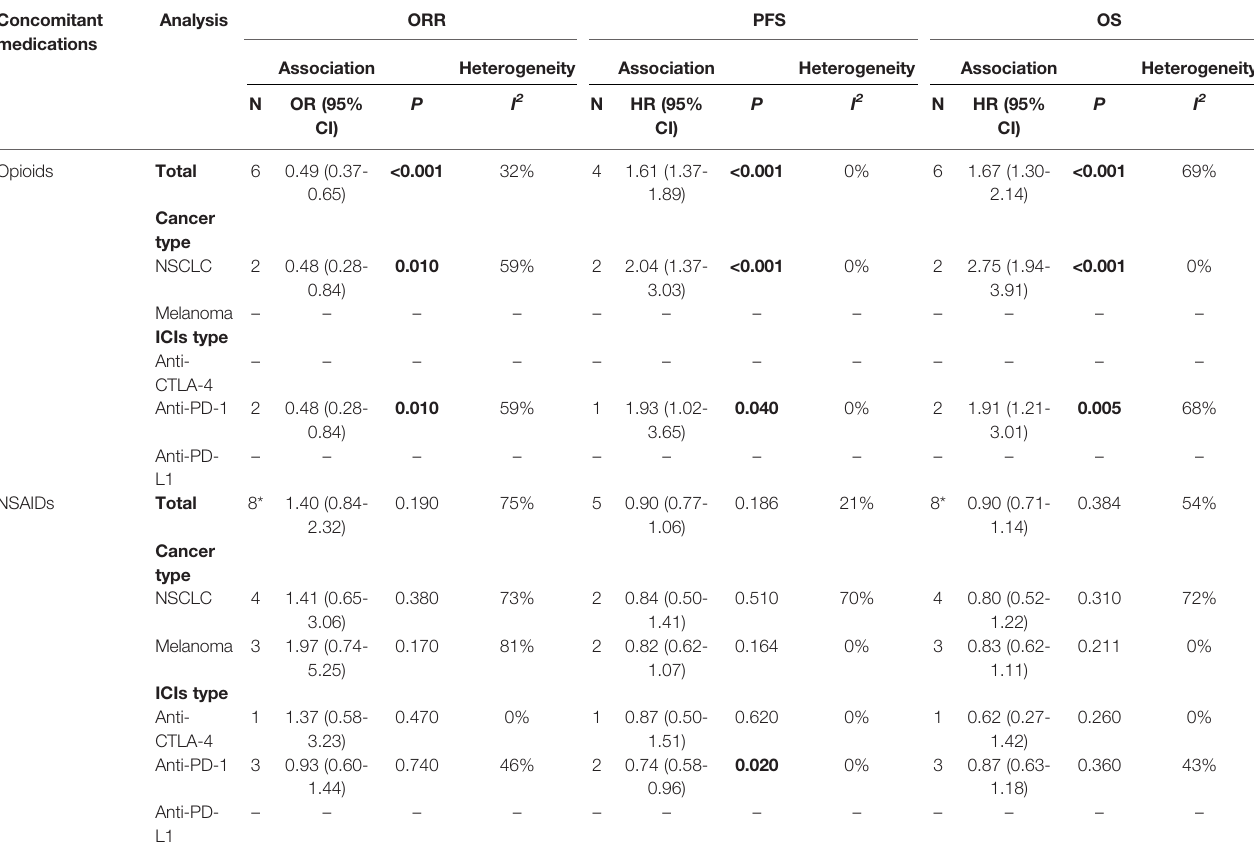
TABLE 2 | Results of subgroup